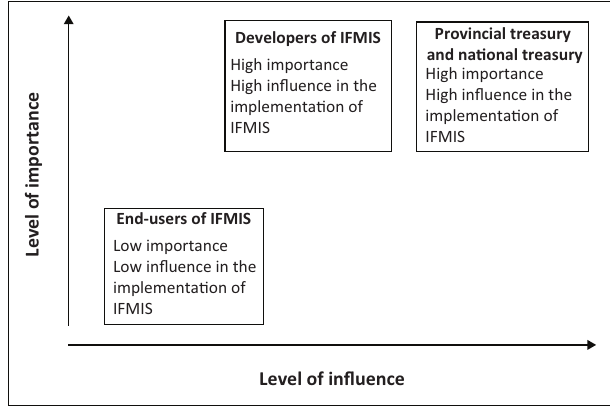
FIGURE 5: Prioritisation of stakeholders in the development of the Integrated Financial Management Information Systems for